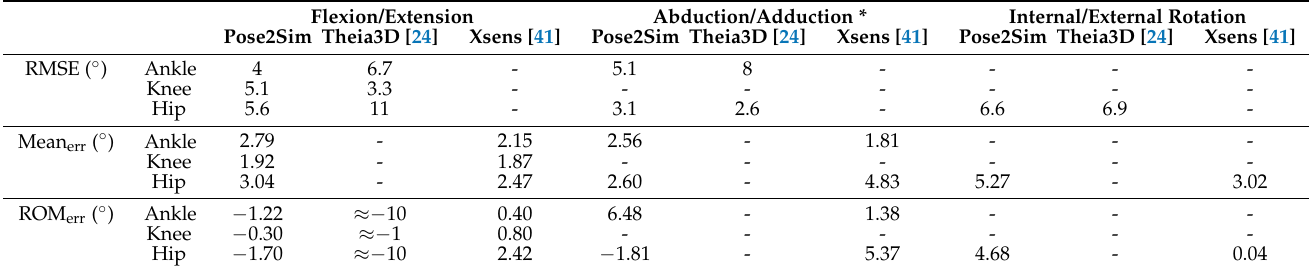
Table 4. Pose2Sim results compared to Theia3D [24] and to Xsens [41] in the walking task. Root-mean- square error (RMSE), mean error (Mean err ), and range of motion (ROM) are examined. Theia3D’s ROM results were approximated from reported graphics along the flexion/extension degree of freedom. Both studies to which we compared our results involved a different setup (participants, cameras, protocol, etc.), therefore the differences cannot be totally attributed to the different technolo- gies (markerless or IMU) nor to the different algorithm (Pose2Sim or Theia3D). * Although ankle subtalar angle combines abduction/adduction and internal/external rotation, it is hereafter